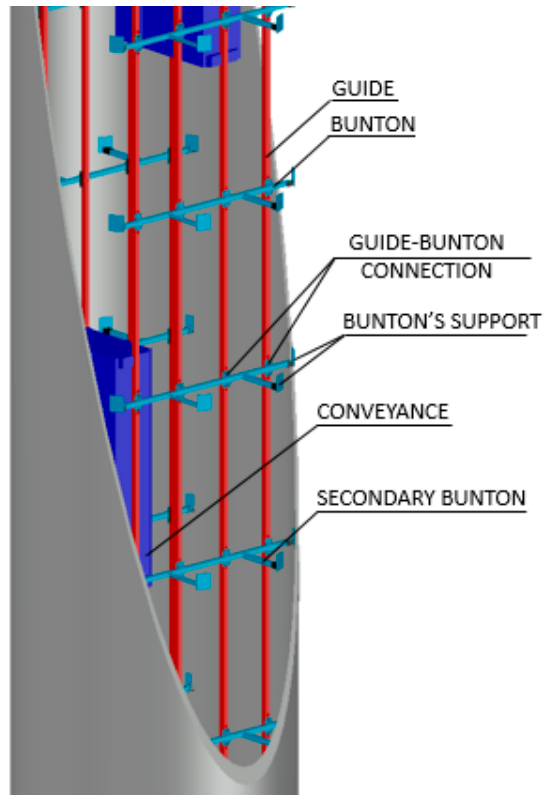
Figure 1. Approximate visualization of a shaft steelwork. Bolted connections are used to connect the members in the structure. Buntons are fixed by short cast iron or steel brackets anchored in the shaft’s concrete lining. Horizontal buntons are configured 4.5 m apart along the shaft axis. Each guide segment is 9 m long and is fixed to three buntons. This system may, therefore, be considered a 3D frame made impact of conveyance guides.